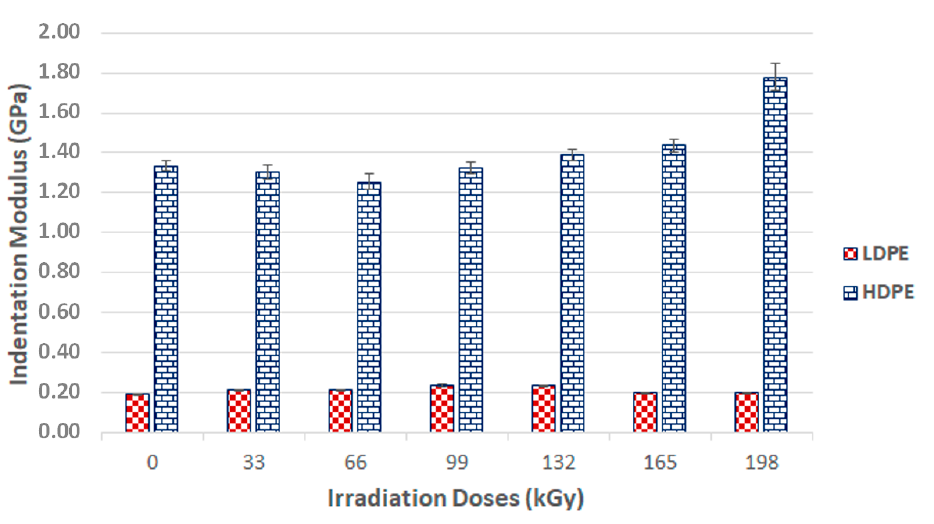
Figure 10. Indentation creep ( C IT ) of irradiated LDPE and HDPE; the vertical line drawn at the top of the column represents the standard deviation.